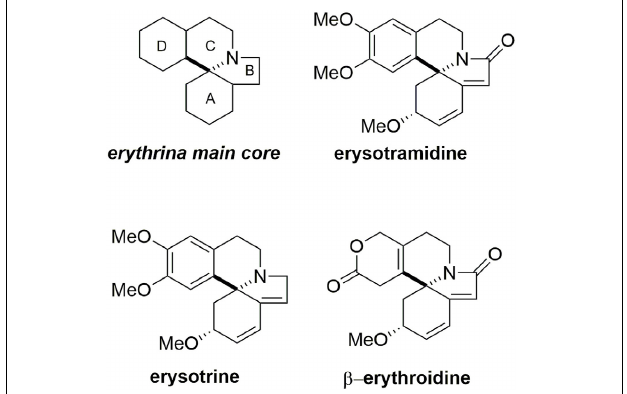
FIGURE 9 | Erythrina alkaloid members.